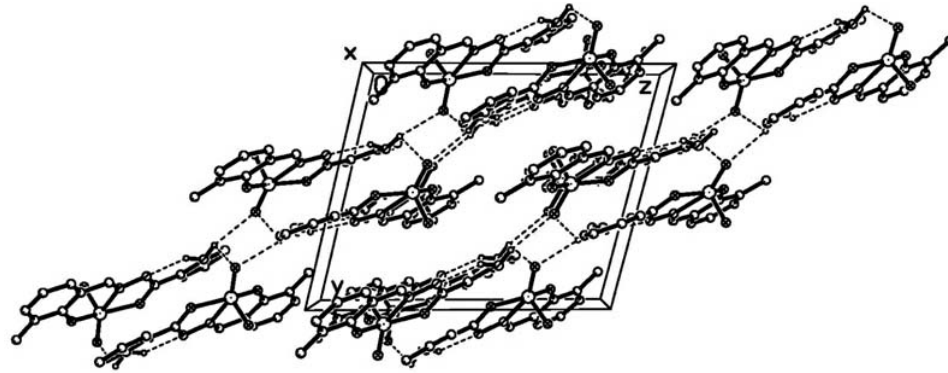
Figure 2. Packing diagram of the complex, viewed along the x axis. Hydrogen bonds are shown as dashed